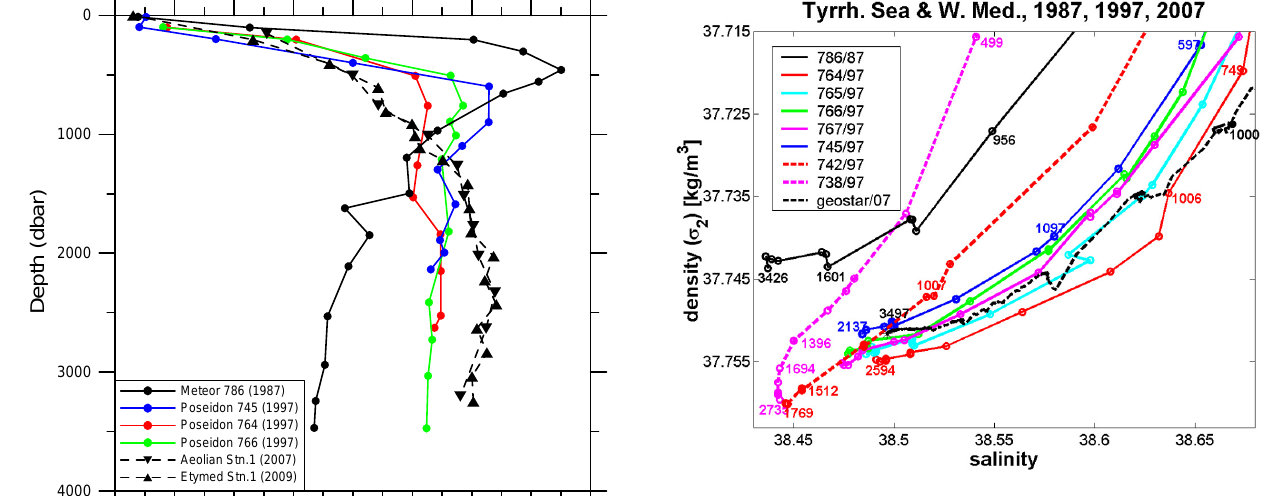
Fig. 3. Density ( σ 2 = potential density anomaly referenced to 2000dbar) versus salinity for Tyrrhenian stations, 1987–2007 and for WMed stations of 1997 (bottle data; the 1997 profiles are in color). For cruises and station positions see Table 1 and Fig. 1, depth markings are in dbar. For the 2007 tracer station a nearby CTD profile is shown (M EDOCC 07, see Table 1), which displays staircase